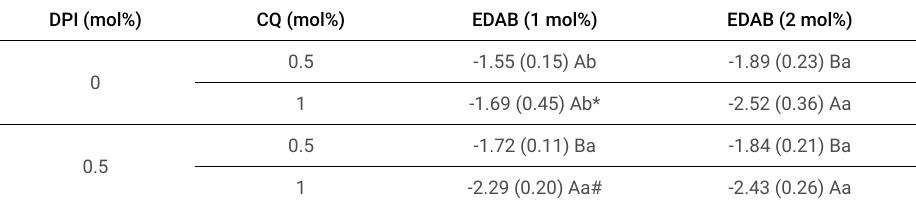
Table 3. Means (standard deviation) of coordinate a*